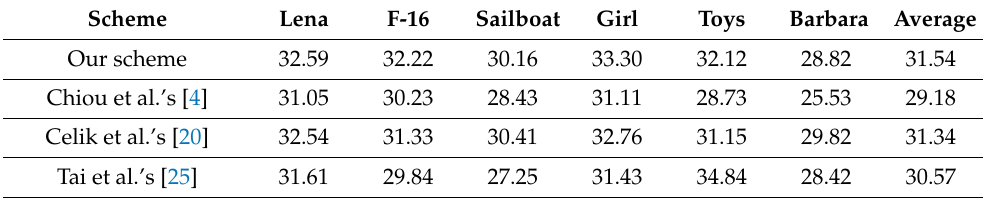
Table 3. Comparative performance of PSNR (dB) for six test images between our method and other